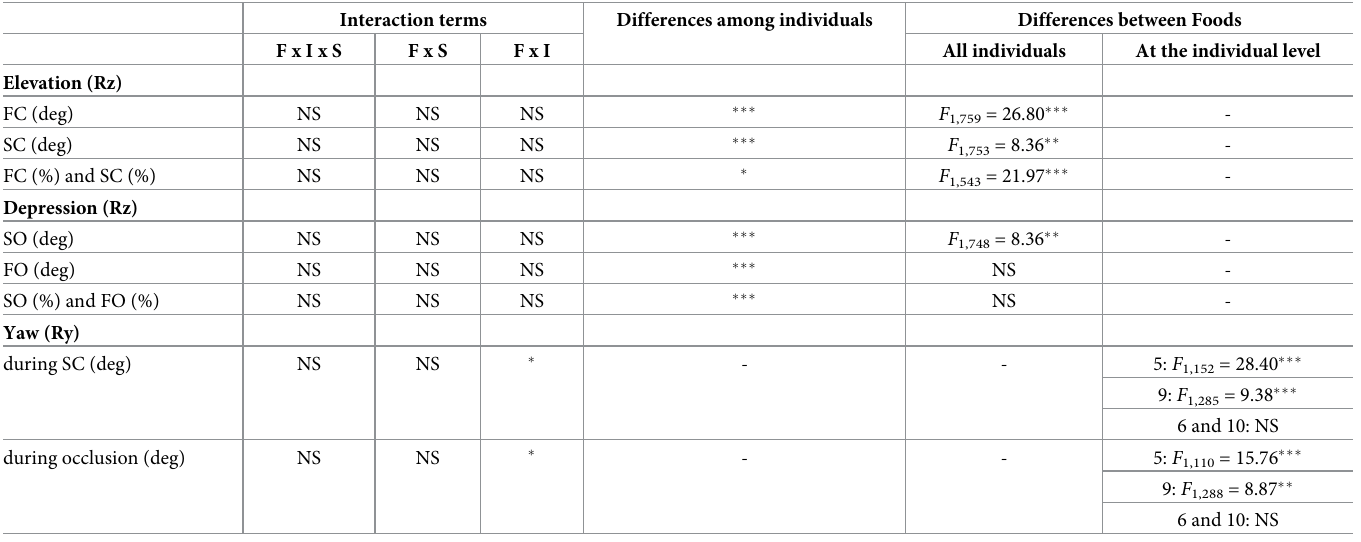
Table 3. Summary of the effects of food toughness (i.e., apple versus carrot) on the amplitude of jaw movements. Interaction